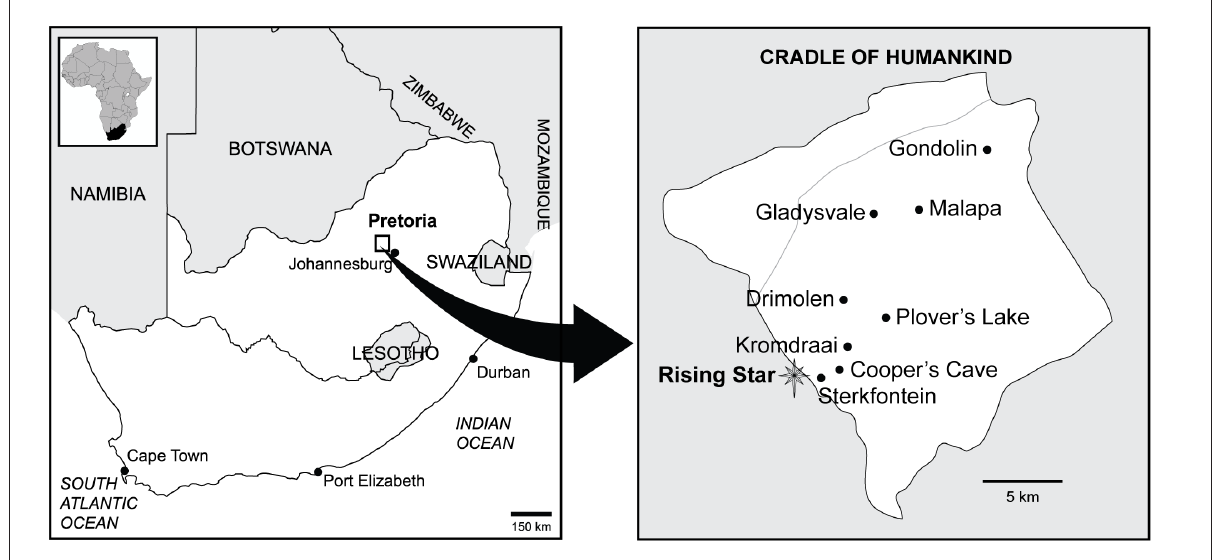
Figure 2: Location of the Rising Star Cave within the Cradle of Humankind, UNESCO World Heritage Site. Other major palaeontological sites are